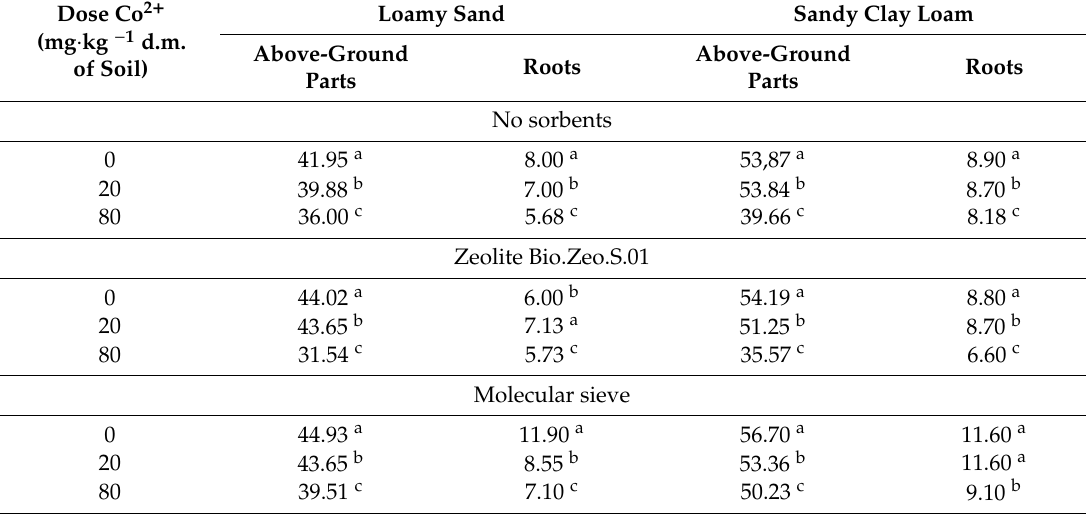
Table 13. The yield of above-ground parts and roots (g d.m. pot − 1 ) of maize from soil contaminated with cobalt with the addition of zeolite and a molecular sieve. Loamy Sand Sandy Clay Loam Dose Co 2 + (mg · kg − 1 d.m. Above-Ground Above-Ground Roots Roots of Soil) Parts Parts